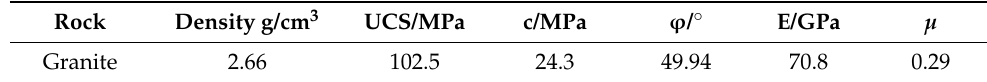
Table 3. Intact rock mean parameters.